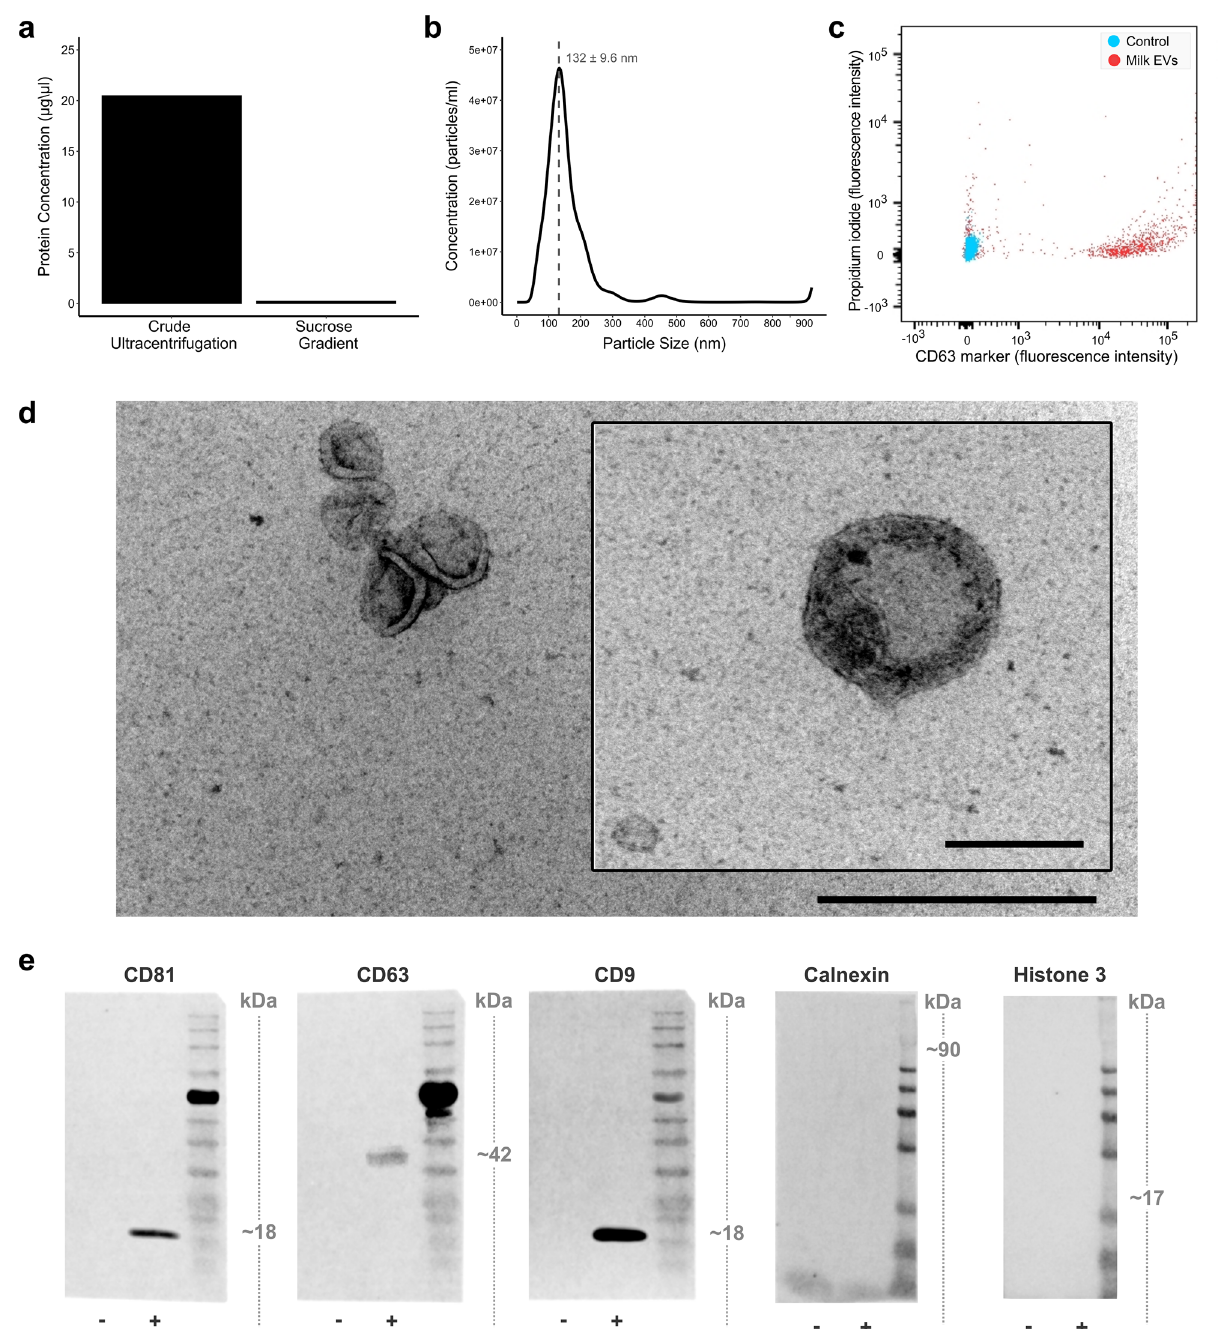
Figure 1. Enrichment and characterization of milk EVs. ( a ) Protein quantification of milk EVs enriched using (1) crude ultracentrifugation (20.48 µg/µl) and (2) ultracentrifugation with sucrose gradient purification (0.21 µg/µl). After ultracentrifugation with sucrose gradient, enriched milk EVs were pooled (n = 3) and characterised by: ( b ) Nanoparticle tracking analysis to demonstrate distribution of particle size and their concentration; ( c ) Flow cytometry to detect the milk EV-associated surface marker CD63 where the X-axis indicates fluorescence intensity linked to CD63, while the Y-axis plots fluorescence of propidium iodide relating to the presence of non-viable cells which are not expected after EV isolation procedures ; ( d ) Transmission electron microscopy to assess morphology, showing milk EVs at 62,000 × magnification (scale bar 500 nm) and a single milk EV at 100,000 × magnification (scale bar 200 nm); ( e ) Full length immunoblots showing positive EV-membrane surface markers CD81, CD63 and CD9, and negative EV-markers calnexin and histone 3. Lanes indicated with negative symbol (−) are negative controls and positive symbol (+) indicate EV protein loading. Figures in panel a and b were generated with GraphPad Prism version 6.0.0 for Windows (www. graph pad. com); image for panel c was exported from FlowJo (www. flowjo.